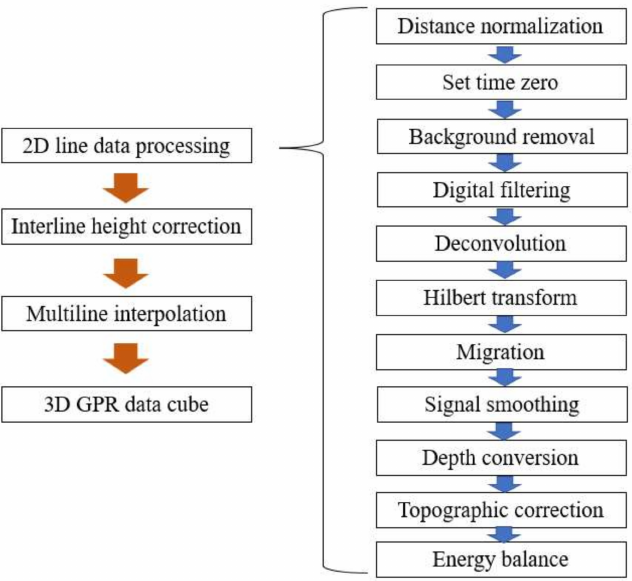
Figure 4. In this study, the GPR data processing process and 3D interpolation